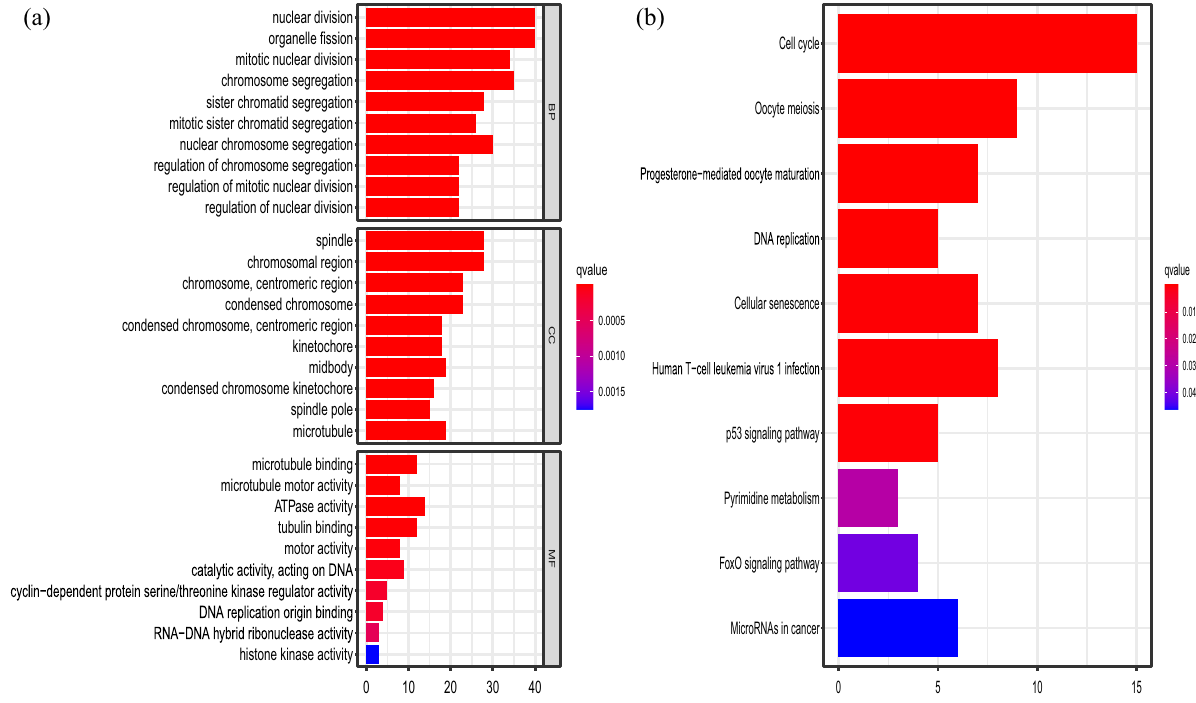
Figure 4: GO ( a ) and KEGG ( b ) pathways enriched in key